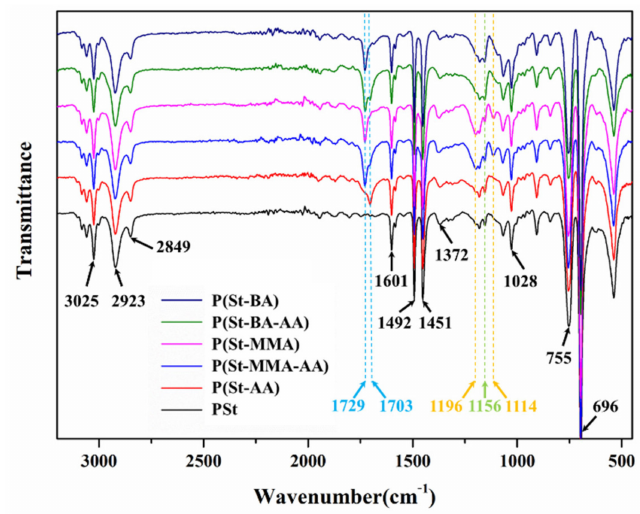
Figure 3. FTIR spectra of PSt-based